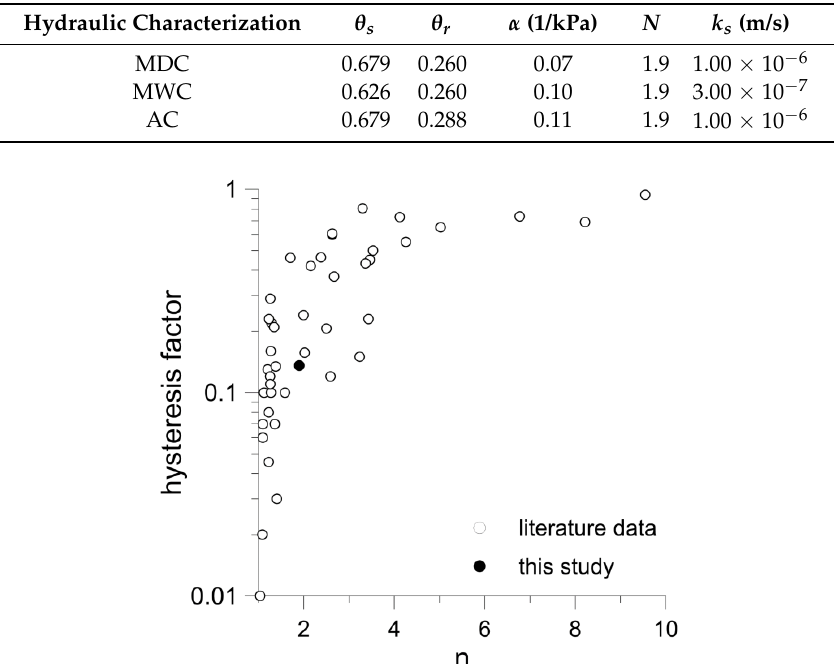
Figure 7. Hysteresis factor as function of parameter n of the van Genuchten model. Hollow circles: data provided by literature datasets, filled circles: values calculated in the present investigation.